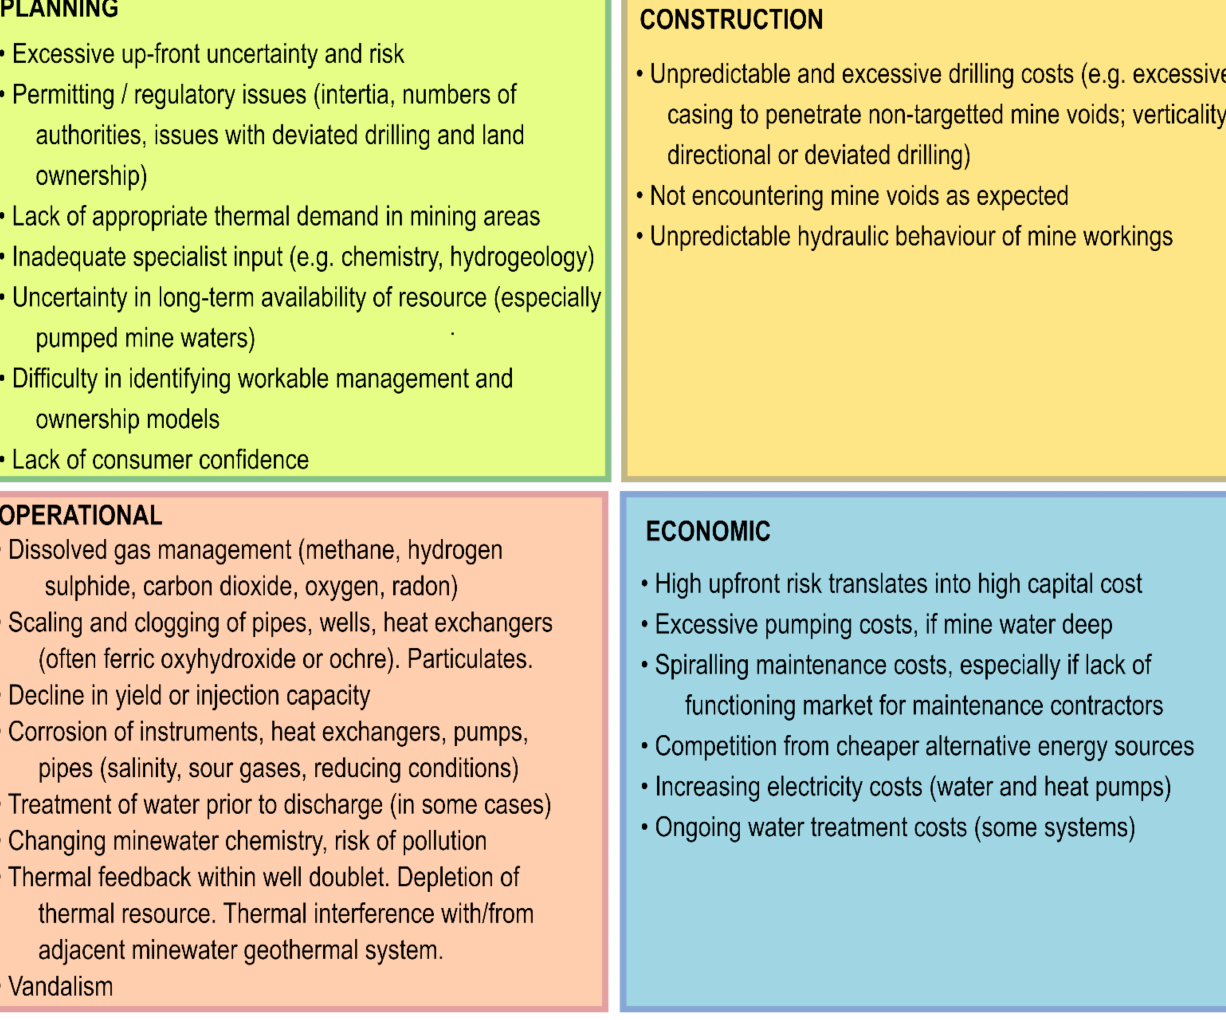
Figure 7. Identified issues which minewater geothermal energy systems may face throughout their project